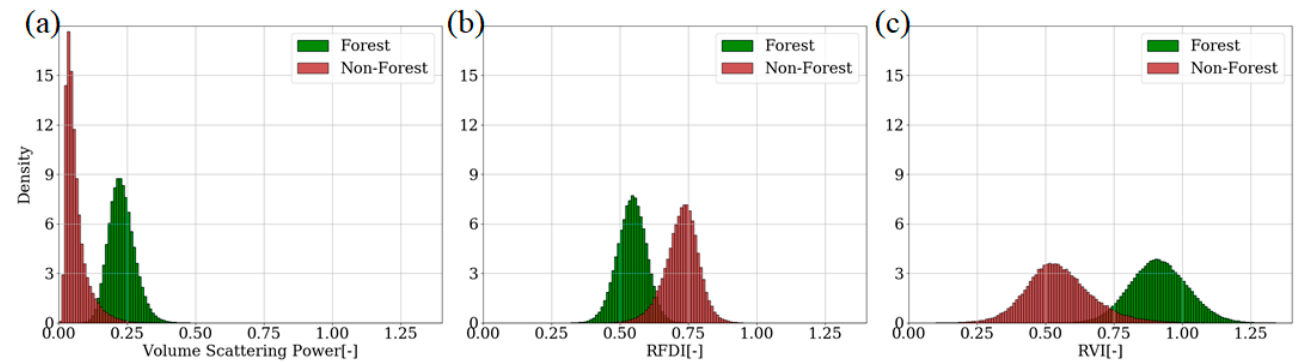
Figure 6. Distributions of the ( a ) volume scattering power, ( b ) RFDI, and ( c ) RVI using the forest and non-forest pixels of the reference data. These values were derived using HH/HV data and a window size of 10 × 20 pixels. Table 7. Forest classification performance with vegetation indices at Rio Branco.